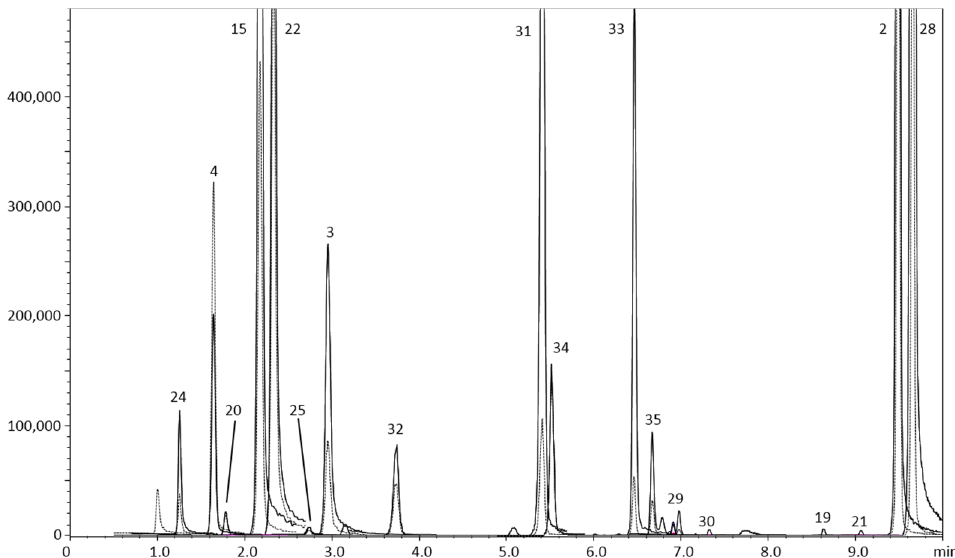
Figure 3. HPLC-MS/MS (in MRM mode) of the oxygen heterocyclic compound profile for sample 10. Quantifier and qualifier ions in continuous and dotted line, respectively. Refer to Table 3 for peak numbers.